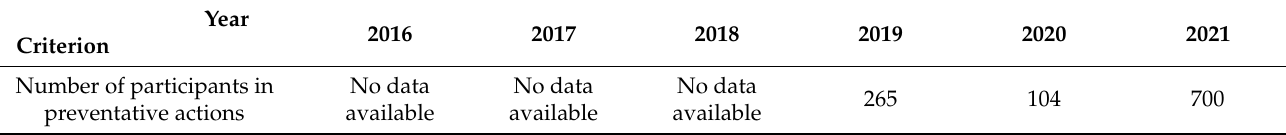
Table 9. Number of participants in preventative actions from 2019 to 2021 (private health